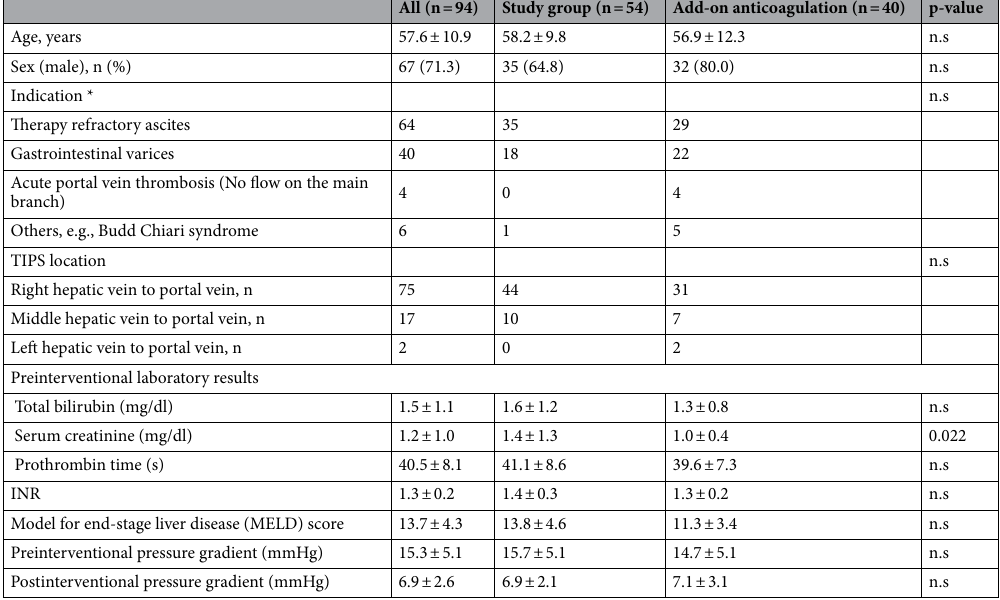
Table 1. Patient characteristics. * more than one possible; n.s., not